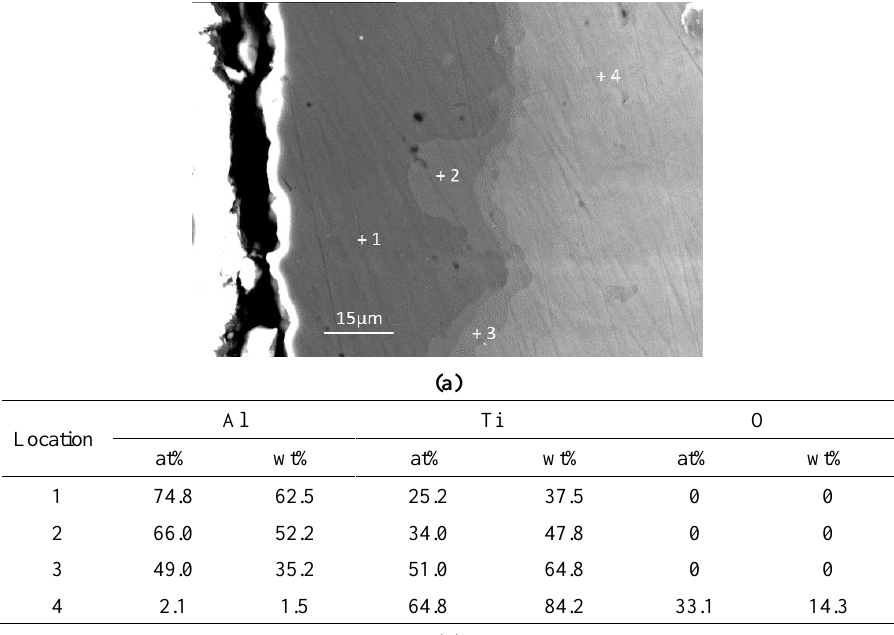
Figure 12. SEM surface morphologies for aluminised Ti and Ti-6Al-4V at 1000 °C for 6 h: ( a ) Ti and ( b ) Ti-6Al-4V. 4. Discussion In the classical aluminisation process by pack cementation, particularly on the Ni- and Fe-based alloys, the metallic powder of Al reacts with an activator (e.g., NH 4 Cl) and forms gaseous aluminium chlorides which transport to the surface of the component to be coated, where the Al chlorides interact with the sample surface and dissociate into the Al atoms and the chlorine anions. The freed Al atoms diffuse into the substrate surface zone to generate a Ni aluminide coating on the Ni-based alloy or a Fe aluminide coating on the Fe-based alloy via interdiffusion. The driving force for the interdiffusion is the activity or concentration gradient between the environment which has the diffusing elements such as Al and the surface of the components (i.e., Ni or Fe). However, the initial stages of the deposition process, particularly during the heating up period, has been overlooked and the formation mechanisms of the aluminide coating have never been studied. The experimental results reported in this paper appear to be never recorded in the literature, particularly, at the early stage of the aluminisation process. In this study, it was found that when Ti